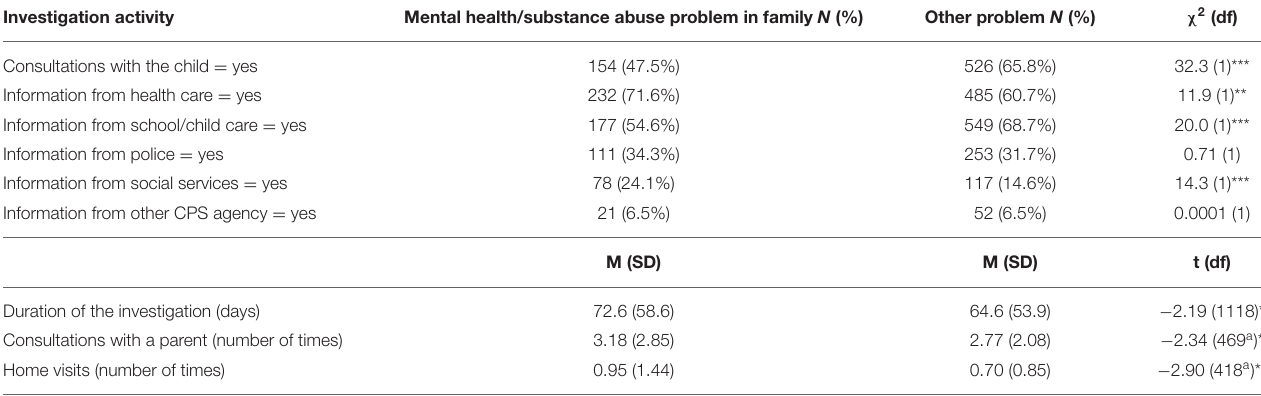
TABLE 1 | CWPS investigations in cases referred for parental mental health problems and/or parental substance abuse vs. other problems ( N = 1,059–1,123). Investigation